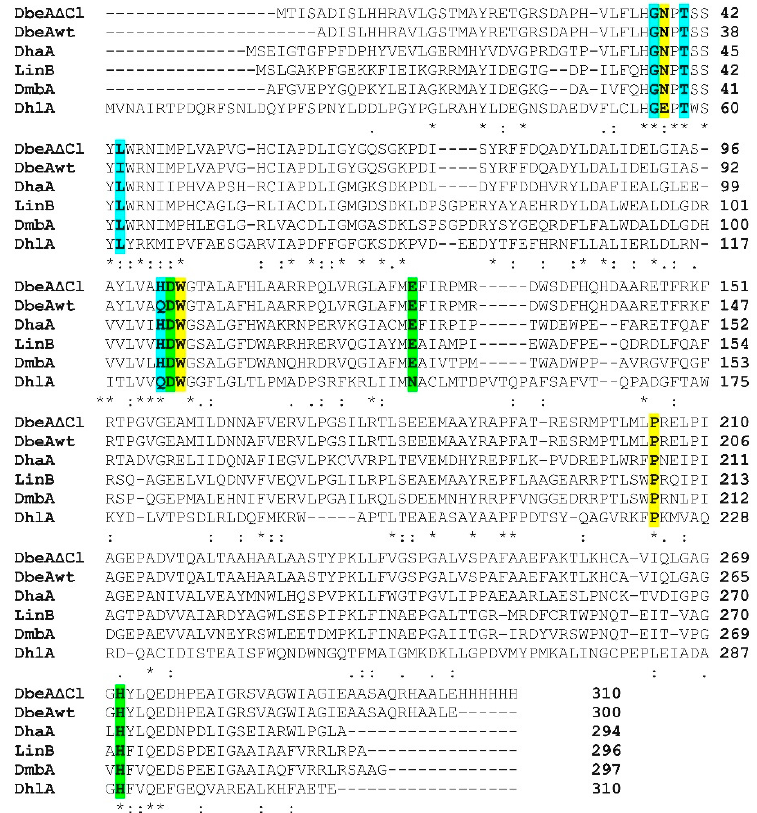
Figure 4. Multiple sequence alignment of DbeA ∆ Cl with five Haloalkane dehalogenases (HLDs) deposited in PDB. Amino acids from canonical HLD active site are highlighted in yellow, catalytic triad residues are highlighted in green and second halide binding site residues are highlighted in cyan. Sequence alignment was performed by ClustalW [32].